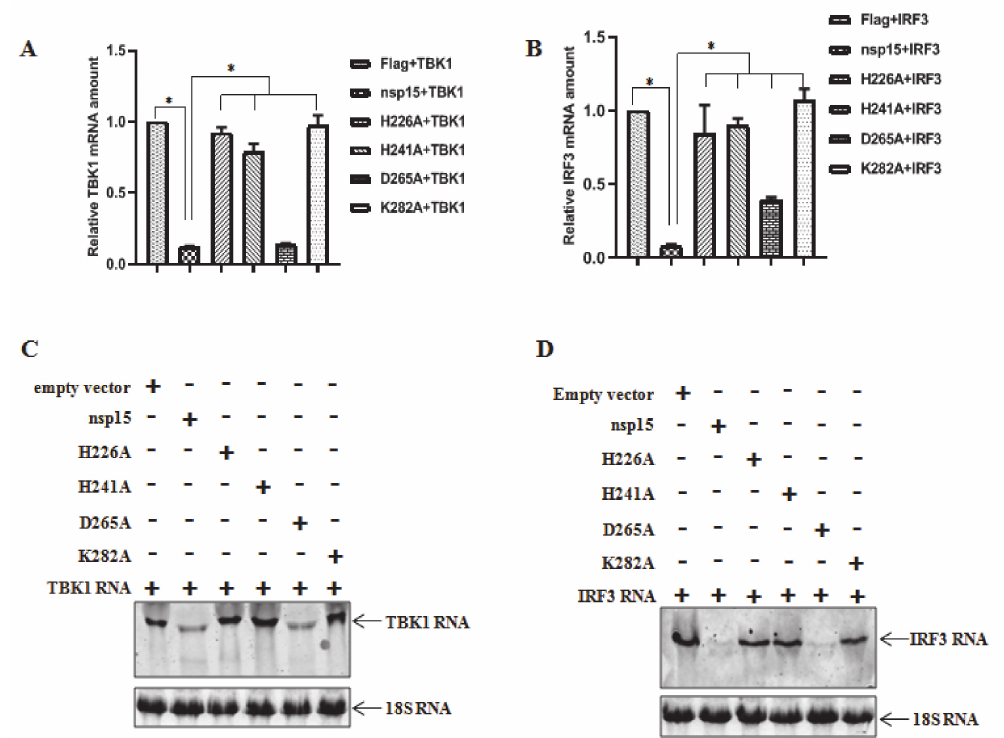
Figure 4. RNA reduction of TBK1 and IRF3 by PEDV nsp15 in an endoribonuclease activity dependent manner. ( A , B ) HEK293T cells were co-transfected with TBK1 or IRF3 and PEDV nsp15 expression plasmid (PEDV nsp15, H226A, H241A, D265A or K282A) or empty vector, followed by